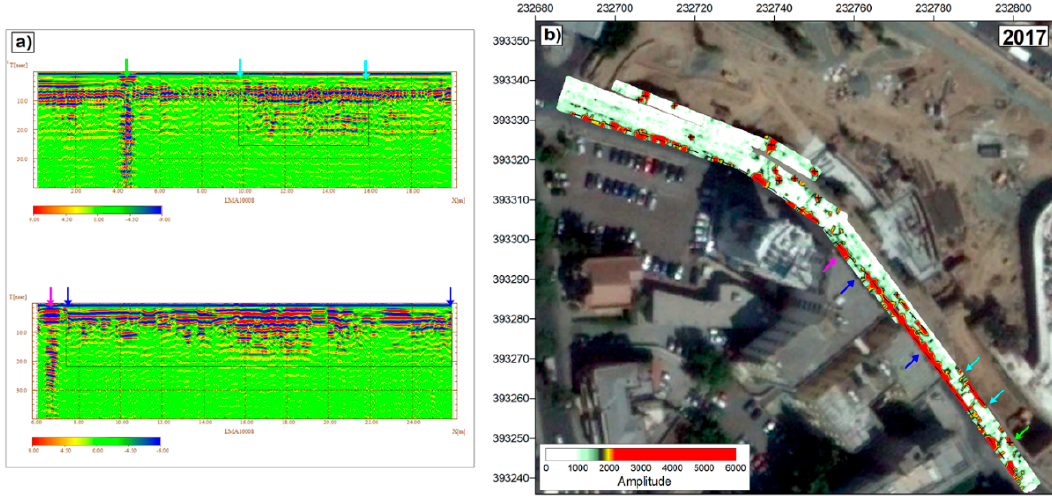
Figure 11. Omirou Avenue: two examples of radargrams ( a ) and GPR slice relative to the time window 10–15 ns. ( b ) Dotted lines and crosses indicate respectively underground pipes and manholes; the colored arrows mark the same anomalies on radargrams and slice.